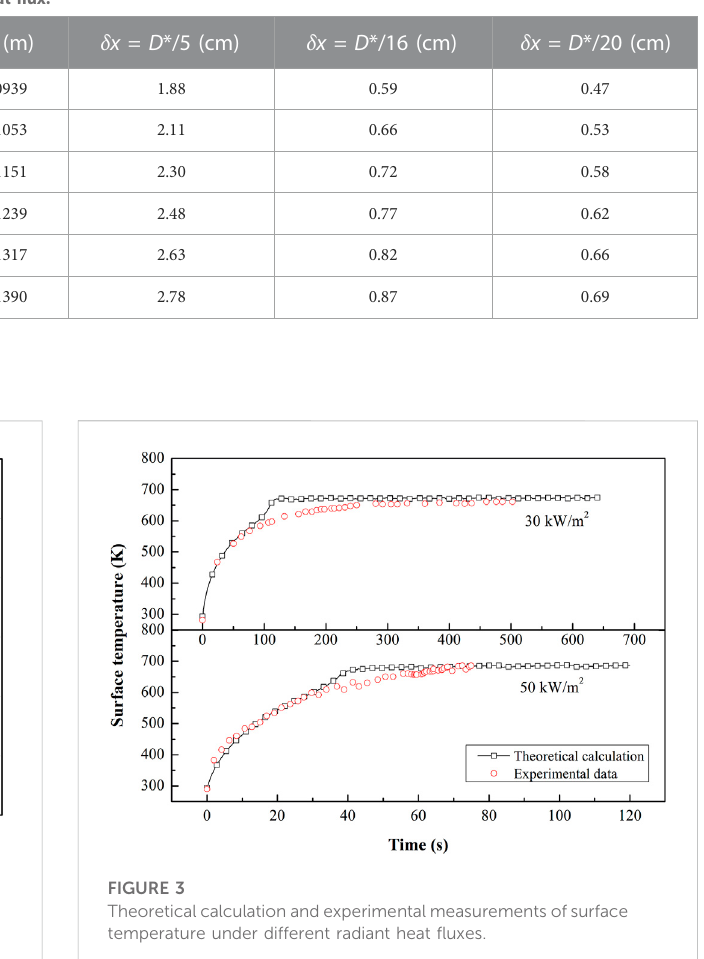
TABLE 2 Calculation results of characteristic diameter under different heat fl ux.